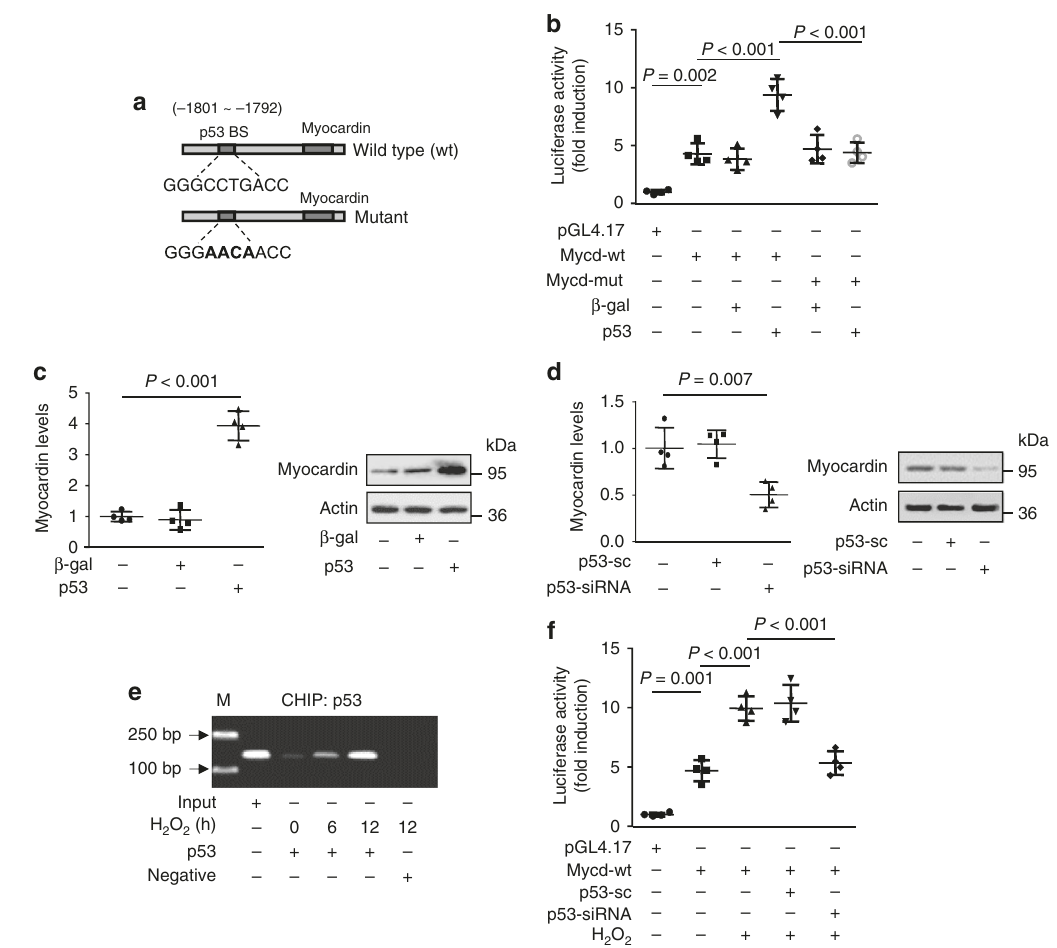
Fig. 2 Myocardin is a transcriptional target of p53. a Mouse myocardin promoter region contains a potential p53-binding site. b p53 promotes myocardin promoter activity. Cardiomyocytes were treated with the adenoviral β -gal or p53, the constructs of the empty vector (pGL-4.17), the wild-type promoter (Mycd-wt) or the promoter with mutations in the binding site (Mycd-mut) respectively. Luciferase activity was assayed. n = 4. c p53 induces the increase of myocardin expression levels. Cardiomyocytes were infected with adenoviral β -gal or p53. Myocardin expression was analyzed by qRT-PCR (left panel) and immunoblot (right panel). n = 4. d Knockdown of p53 reduces the myocardin expression. Cardiomyocytes were infected with adenoviral p53-siRNA or p53-sc. Myocardin levels were analyzed by qRT-PCR (left panel) and immunoblot (right panel). n = 4. e ChIP analysis of p53 binding to the promoter of myocardin. Cardiomyocytes were treated with H 2 O 2 at indicated time. CHIP was performed with p53 or β -actin (negative) antibody. f Knockdown of p53 inhibits the increase of myocardin promoter activity induced by H 2 O 2 . Cardiomyocytes were treated with the adenoviral p53-siRNA or p53-sc, the constructs of the empty vector (pGL-4.17), or the wild-type promoter (wt), and then were treated with H 2 O 2 . Luciferase activity was assayed. n =